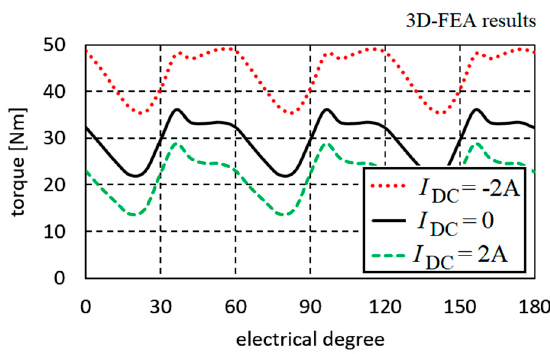
Figure 6. Torque ripple at AC 30Arms at different DC field excitations for the UB1 rotor concept.